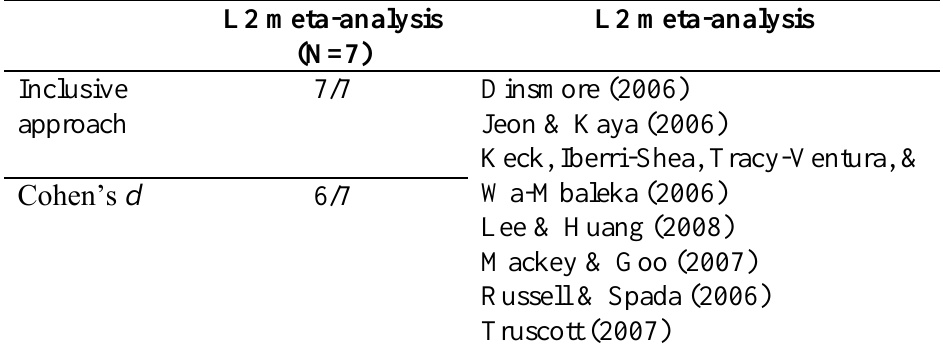
Influence of Norris and Ortega (2000) on subsequent L2